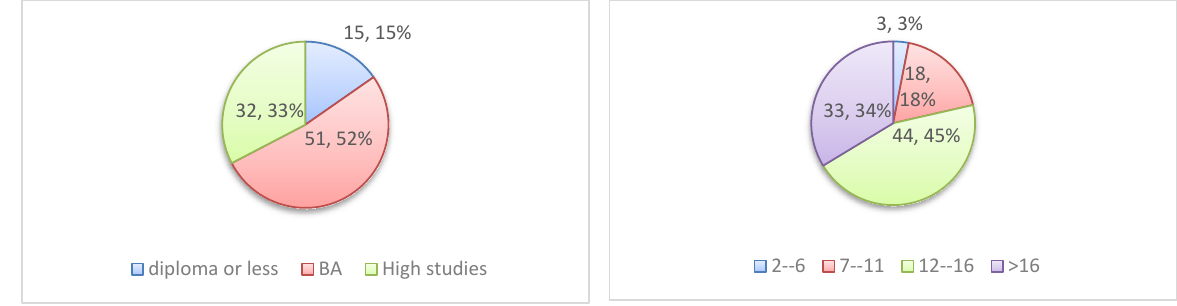
Fig. 2. Personal characteristics of the participants